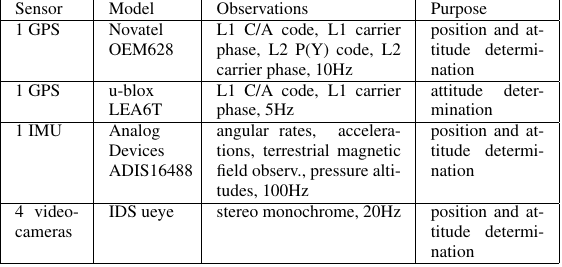
Table 1: Onboard direct georeferencing sensors.